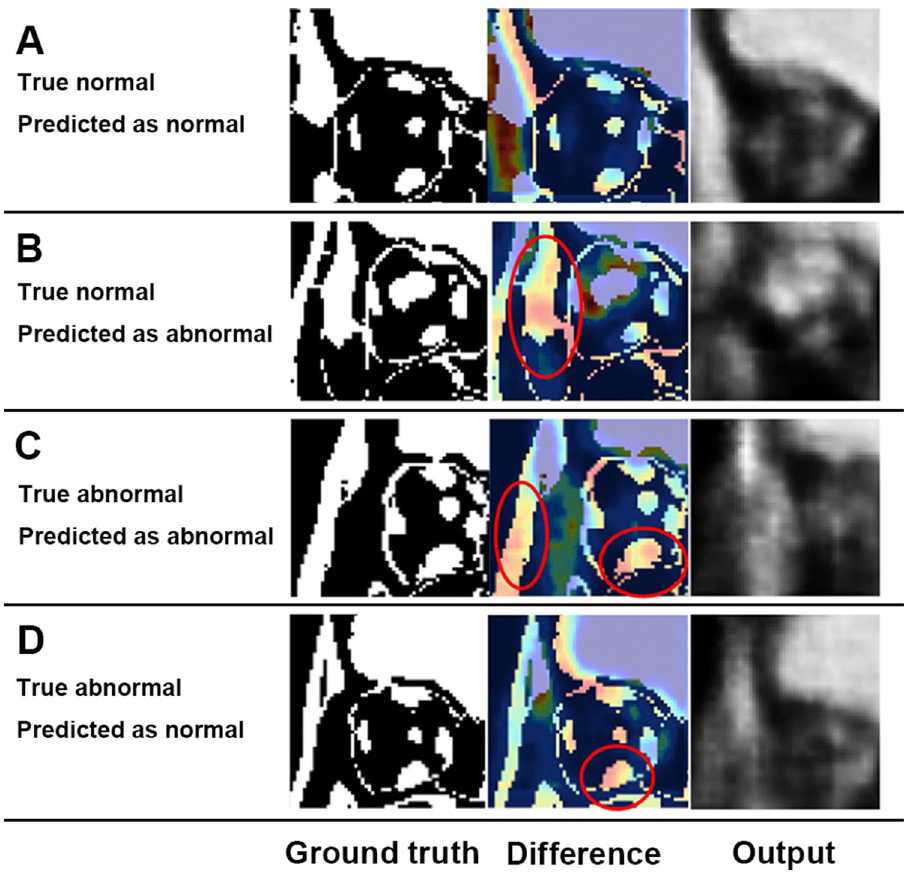
Figure 4. ( A ) Representative normal CT images correctly identified by the model. ( B ) Representative presentation of normal CT images erroneously identified as abnormal. Differences between input and output images are also seen in extraorbital structures (red hollow circles). ( C ) Representative presentation of abnormal CT images correctly identified by the model. Differences between input and output images present in the inferior rectus muscle and extraorbital structures (red hollow circles). ( D ) Representative presentation of abnormal CT images erroneously identified as normal. Differences between input and output images are mainly present in the inferior rectus muscle. However, the total loss values of these images did not exceed the best cut-off value. The ground truth images (left) represent input images. The output images (right) represent images passed through the 3D VAE model. The difference map shows pixel-wise squared difference between input and output images. A large difference is represented by red